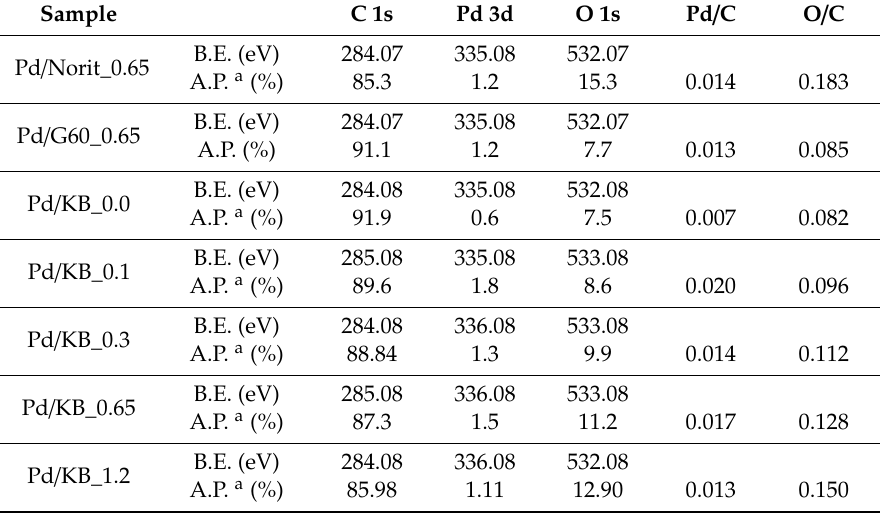
Table 4. C 1s, Pd 3d, and O 1s amount obtained from survey spectra of XPS analyses.